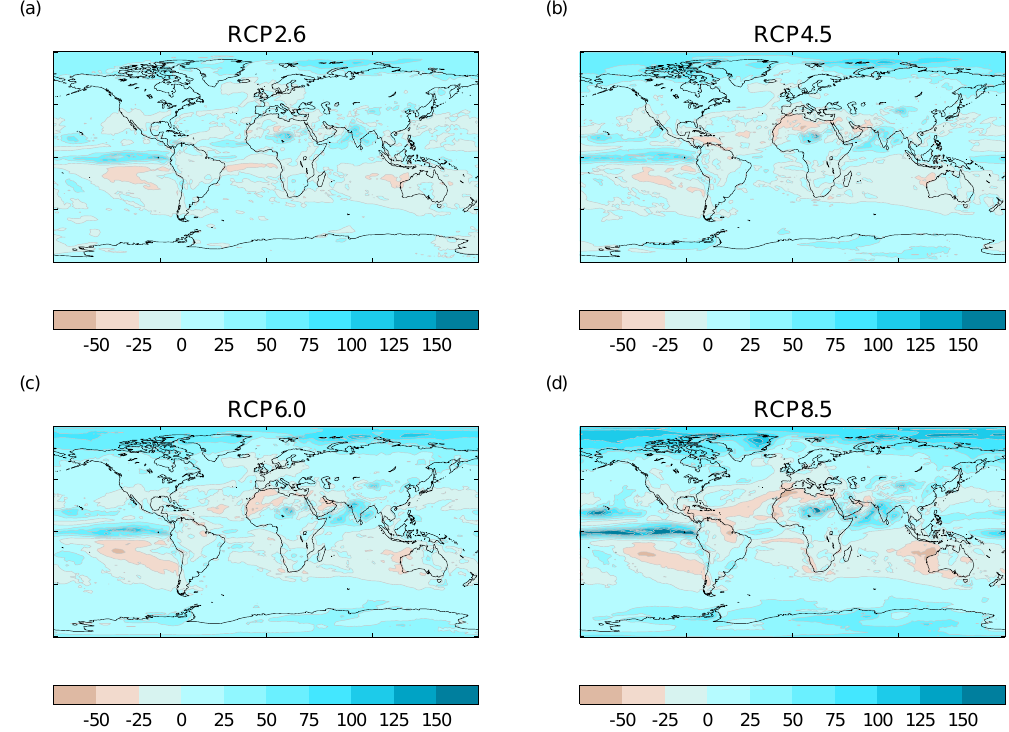
Figure 5. Global patterns of percentage change in annual mean precipitation by 2070–2099 relative to 1971–2000, for (a) RCP2.6, (b) RCP4.5, (c) RCP6.0 and (d)